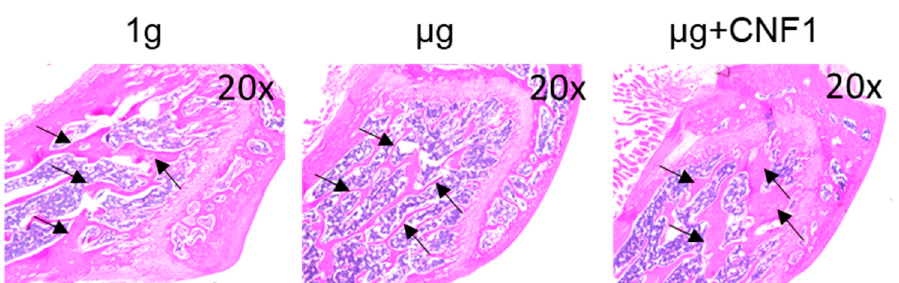
Figure 5. Measurement of mouse proximal trabecular structures by histology in HU-treated (µg), HU+CNF1-treated (µg + CNF1) and control (1g) mice. Compared to the control group, H/E bone sections of HU-treated (µg) mouse tibias showed significantly thinner trabecular structures than control (1g) mice; and administration of CNF1 converted HU-affected trabecular bone formation in HU-CNF1-treated (µg + CNF1) mice. Black arrows represent trabecular bone structures. Magnification: 20 ×. One representative bone sample of three to four is shown.